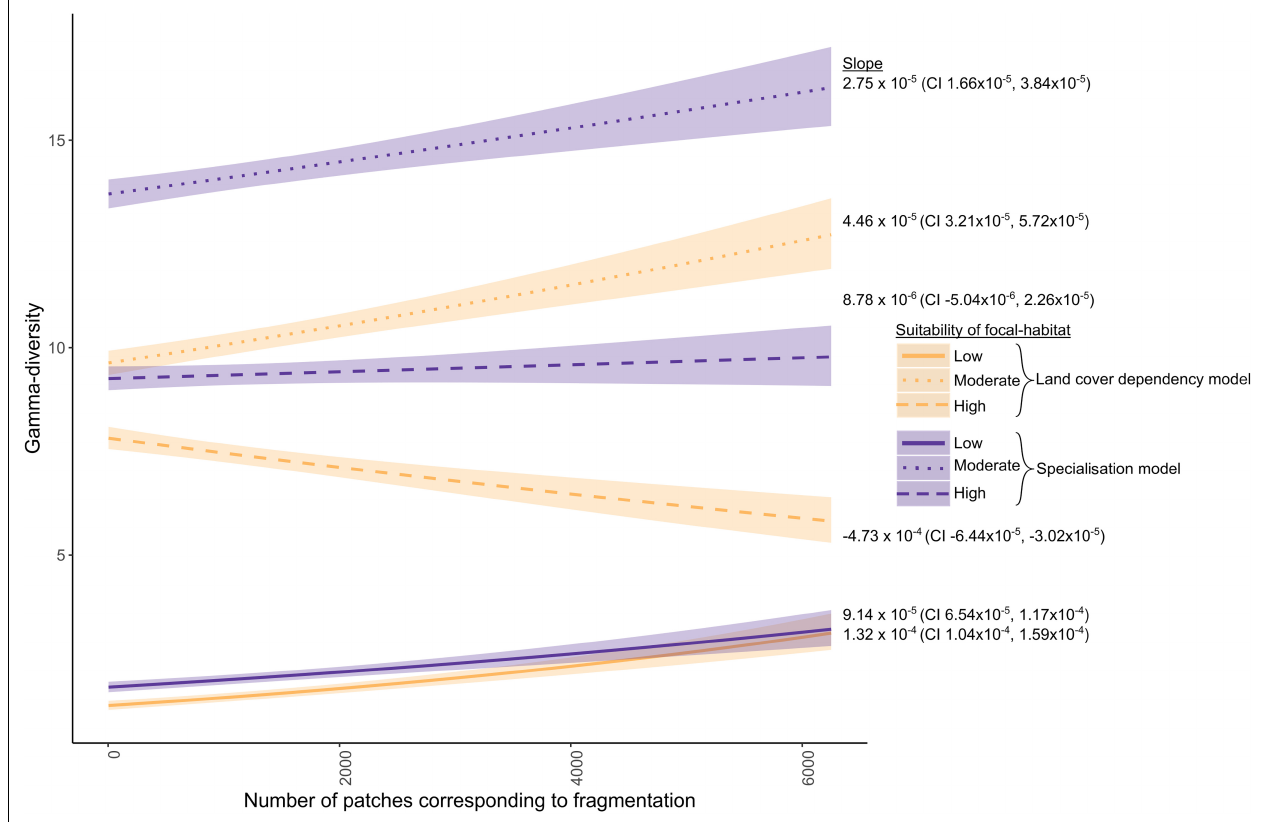
FIGURE 5 | Gamma-diversity for three groups of species – those for whom the focal-habitat had high, moderate, or low suitability – for the habitat dependency model (habitat bias and mortality slope 0.75) and specialization model (habitat bias and mortality slope 1 and 0.5, respectively). Gamma-diversity increased with FPS in both models for the species who for whom the focal-habitat had low or moderate suitability, and those for whom the focal-habitat had high suitability in the specialization model. By contrast, in the habitat dependency model, gamma-diversity declined with increasing FPS for the species for whom the focal-habitat had high